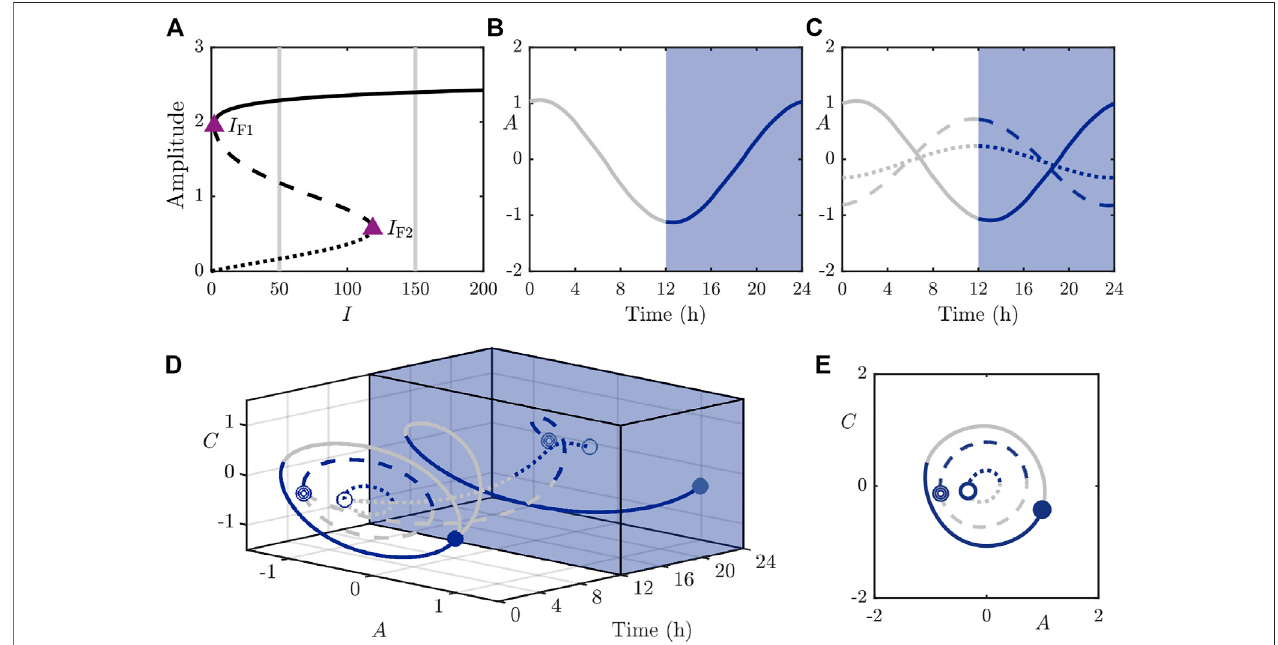
FIGURE 3 | The stable (solid), saddle (dashed), and fully unstable (dotted) periodic orbits in the 2D model. (A) : Bifurcation diagram of the periodic orbits under variationof I withotherparametersasin Table1 .Purpletrianglesmarkfoldsofperiodicorbitsatapproximately I F1 ≈ 2 . 1and I F2 ≈ 118 . 6.Theverticalgreylinesshowthe values of I used in panels (B) and (C) . (B – C) : Time series plots of the orbits over a 24 h period for I (cid:1) 150 [panel (B) ], and I (cid:1) 50 [panel (C) ]. Grey portions of the orbits correspondto f ( t ) (cid:1) 1,andnavyportionscorrespondto f ( t ) (cid:1) 0(shaded). (D – E) :Orbitsfor I (cid:1) 50,asshowninpanel (C) ,plottedovera24hperiod.Theprojection oftheseorbitsontoaplaneatzerophaseoftheforcingcycle[i.e.,where f ( t ) switchesfrom0to1]isshownonthefront-facingsurface[Time (cid:1) 0h]ofpanel (D) andinthis ( A , C ) -plane alone in panel (E) . The markers show the location of the periodic orbits at the zero phase of the forcing cycle.